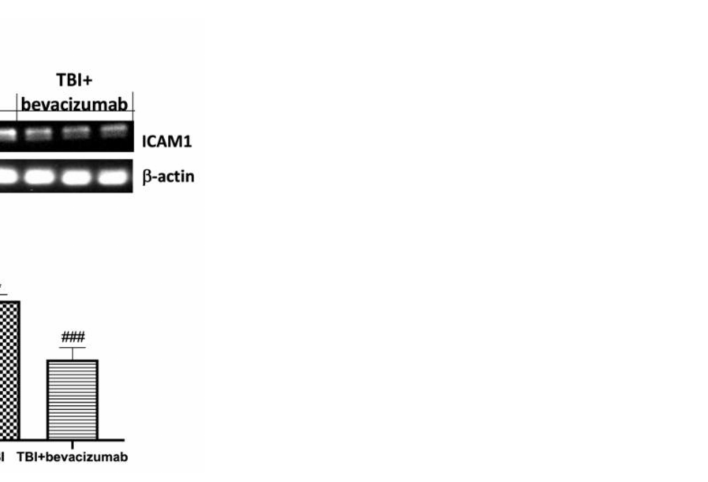
Figure 3. Effects of bevacizumab on VEGF, TJs and ICAM1 expression 24 h after TBI. TBI activates the VEGF ( A , A1 ) protein and reduces the expression of ZO-1 ( B , B1 ), Occludin ( C , C1 ), Claudin-5 ( D , D1 ) and ICAM1 ( E , E1 ). On the other hand, treatment with bevacizumab limits the expression of VEGF ( A , A1 ) and the alteration of ZO-1 ( B , B1 ), Occludin ( C , C1 ), Claudin-5 ( D , D1 ) and ICAM1 ( E , E1 ). Data show one representative blot from three independent experiments with similar results. Data are expressed as mean ± SD from n = 5 mice/group. *** p < 0.001 vs. Sham; ## p < 0.01 and ### p < 0.001 vs. TBI.